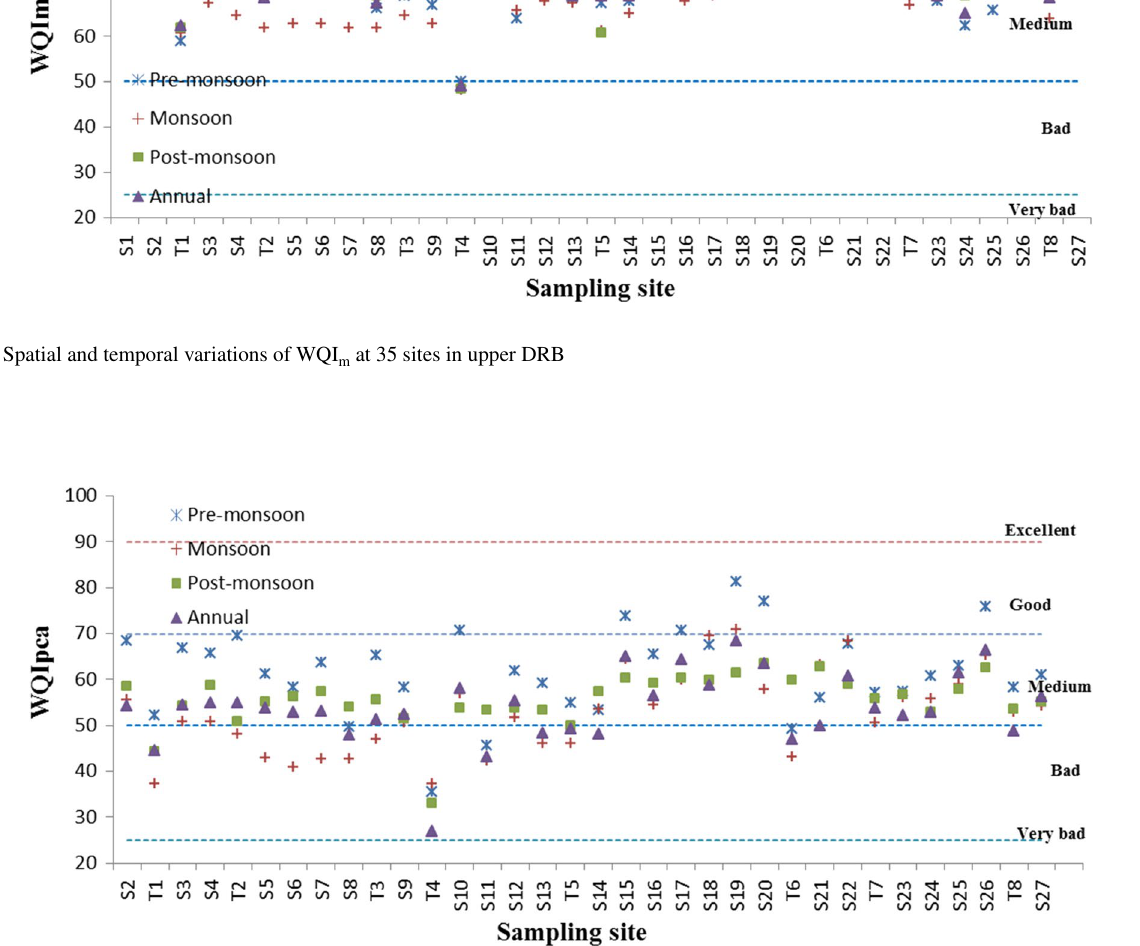
pca at 35 sites in upper DRB